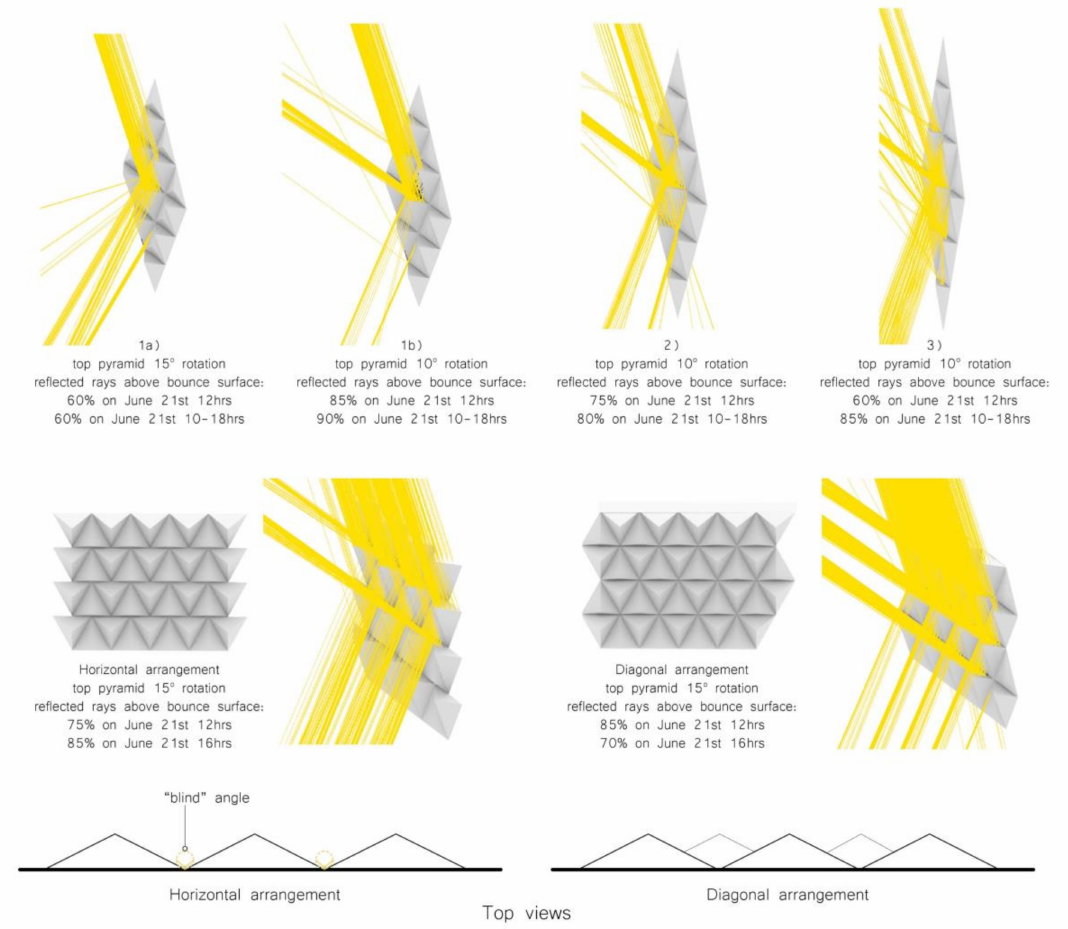
Figure 8. Top : Summary of the sun ray trace analysis studies and in comparison to the façade arrangement. Bottom : The impact of the “blind” angle impact and the difference between the horizontal and diagonal